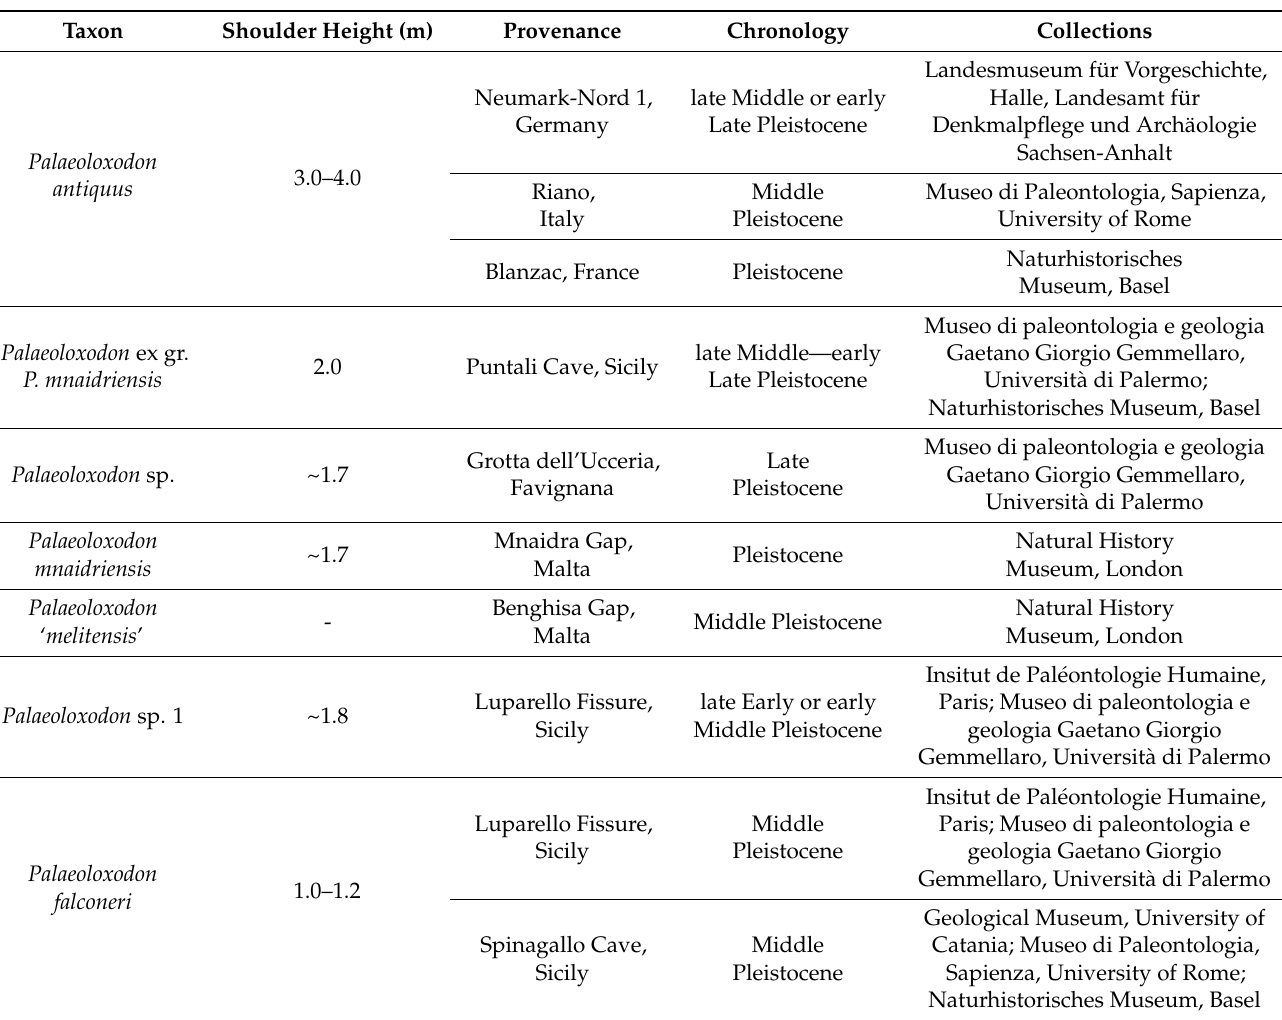
Table 1. Elephantinae taxa sampled, their geographic provenance, approximate adult skeletal height, geochronological age and collections provenance. Shoulder heights are based on Scarborough [8]. Additional measurements from the literature [5–8] are included and acknowledged in the captions of Figures 3 and